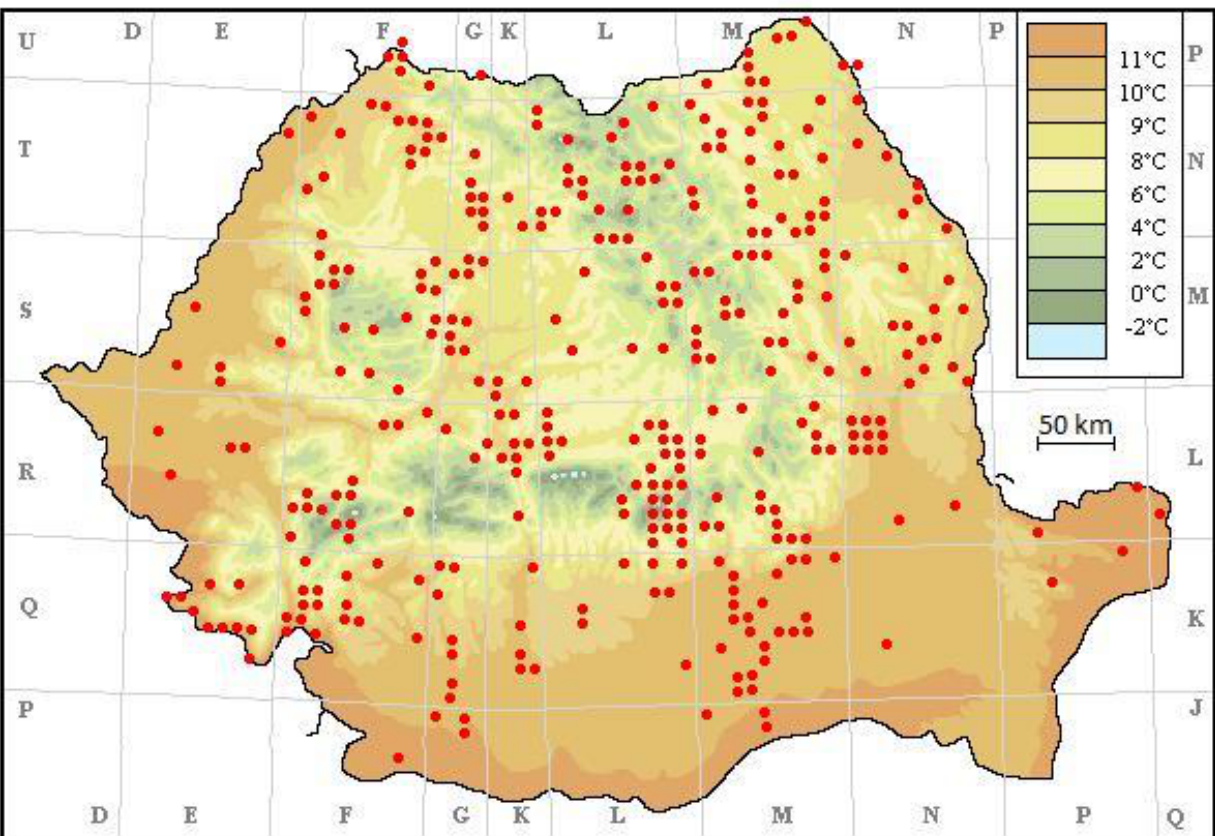
Figure 3. Distribution of Salix alba communities.